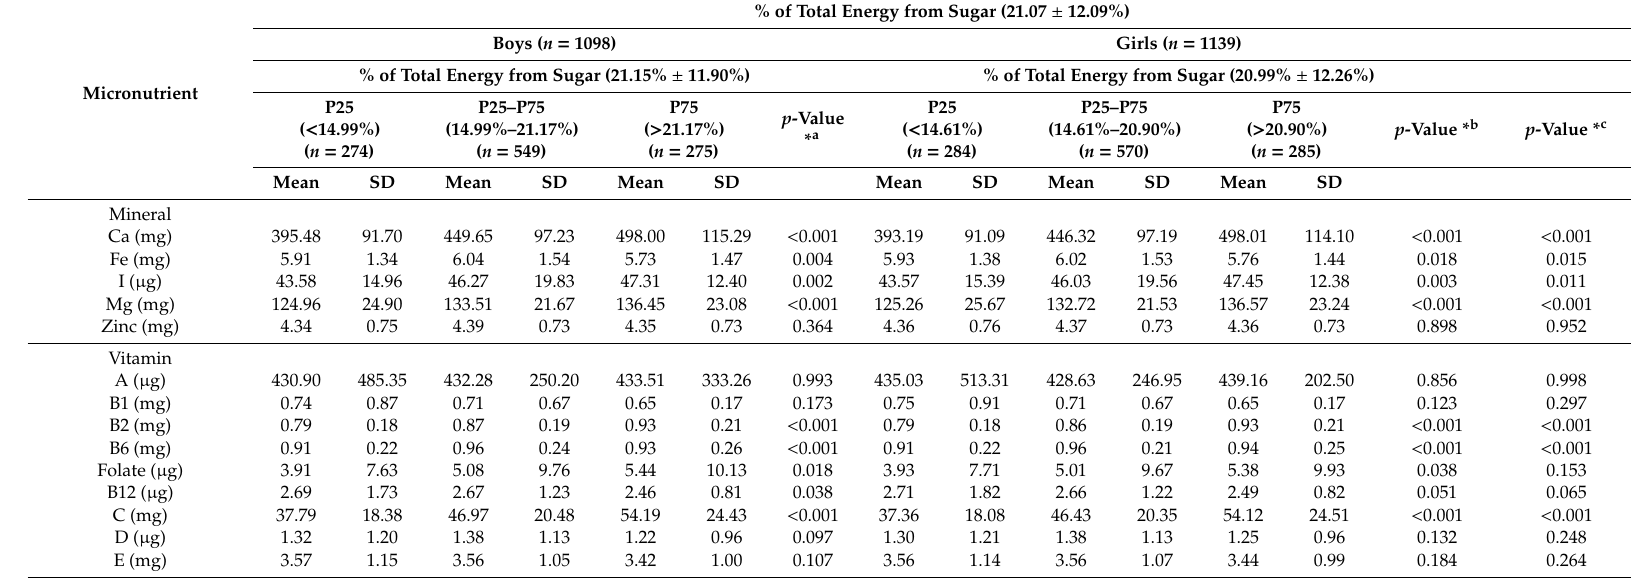
Table 11. Micronutrient intake consumed by percentage of total energy derived from total sugar intake by 6–8 years old children ( n = 2237) in Valencia, Spain,